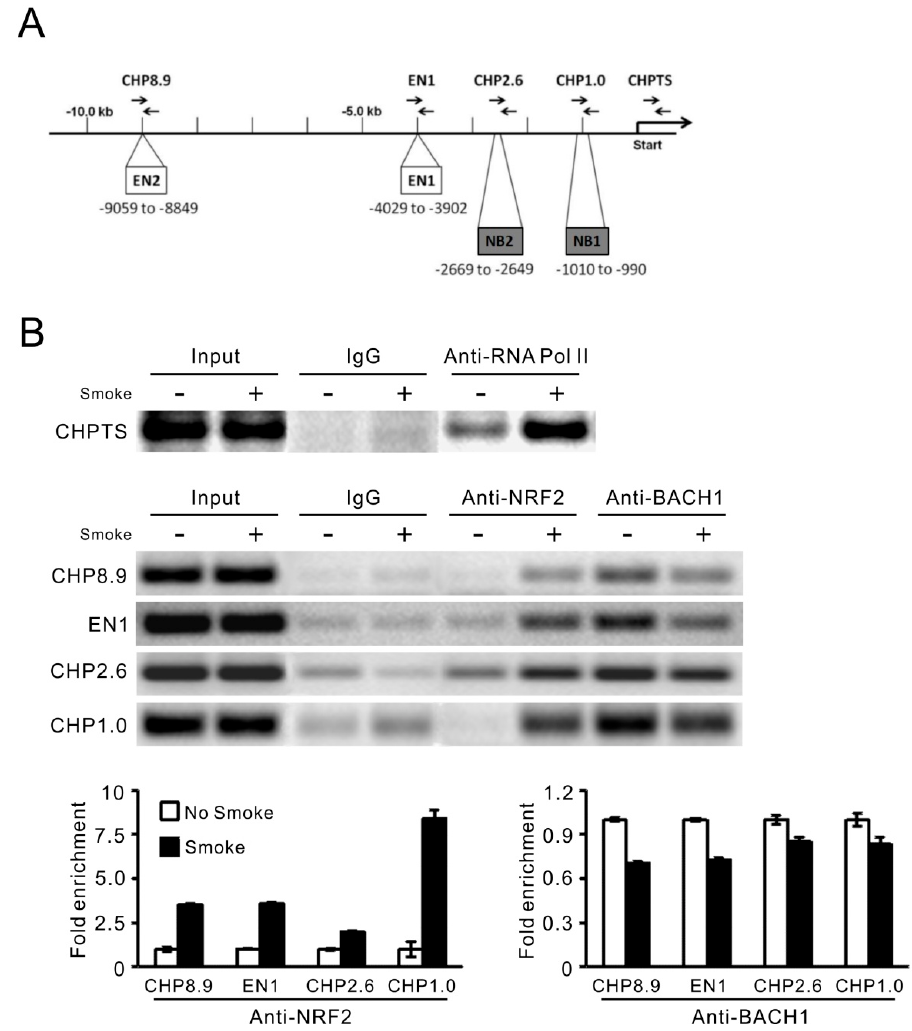
Figure 6. The binding sites and abilities of NRF2 and BACH1 to the HO-1 promoter. ( A ) Diagram of putative ARE enhancer sites in the HO-1 promoter regions for NRF2 and BACH1 binding and primers used for the ChIP assays; ( B ) ChIP assay analysis for binding of NRF2 and BACH1 to the HO-1 gene ARE. HBE1 cells after smoke treatment were collected at 6 h, fixed in formaldehyde, and ChIP analysis was performed using IgG, NRF2 and BACH1 antibodies. The immunoprecipitated chromatin was PCR-amplified, run on agarose gel and photographed. The mean enrichment intensities are shown in the bottom panel as fold relative to that of untreated HBE1 cells ( n = 3; mean ± S.D.).